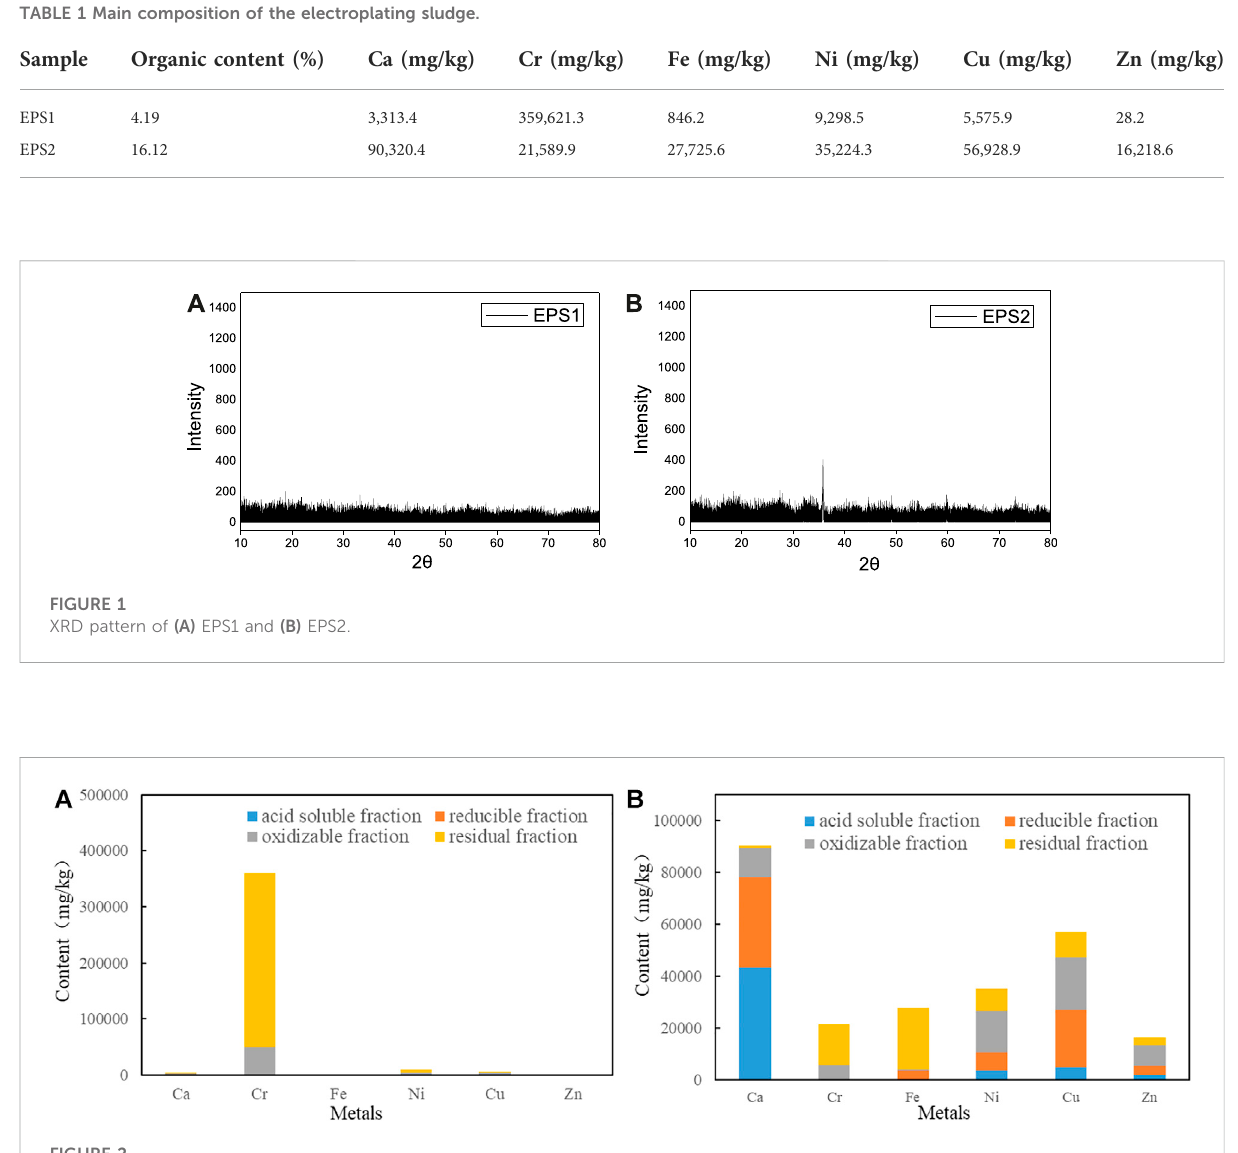
FIGURE 2 Fractions of Ca, Fe, Cu, Ni, Zn, and Cr by BCR analysis in (A) EPS1 and (B)